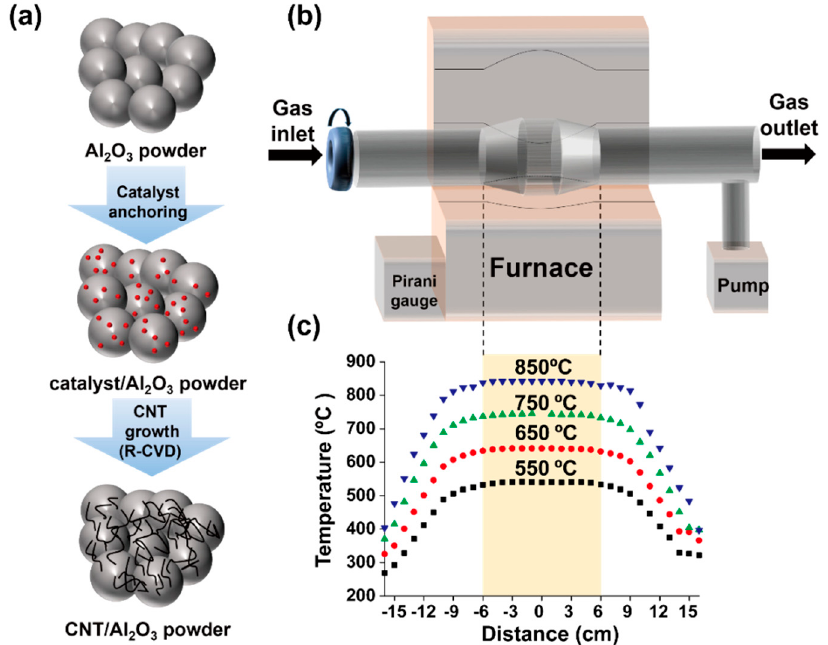
Figure 1. Schematic illustration of ( a ) experimental procedure and ( b ) rotatable CVD (RCVD) apparatus. ( c ) Temperature profiles in the RCVD chamber were measured with a thermocouple at various temperatures.